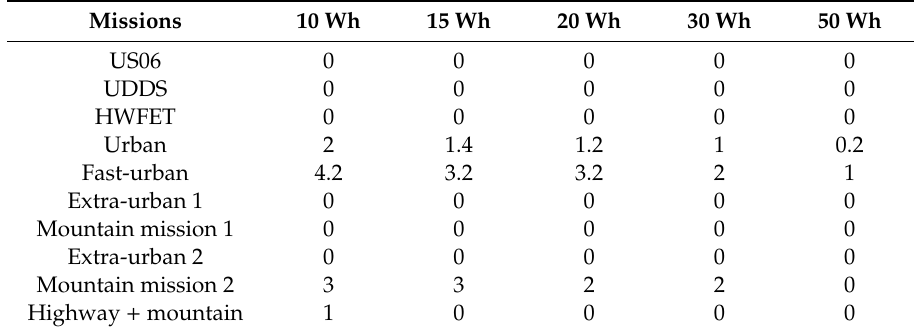
Table 5. Internal Combustion Engine (ICE) number of starts when speed is below USL, as a function of Low Speed Zone (LSZ) sizing (i.e., LSZ